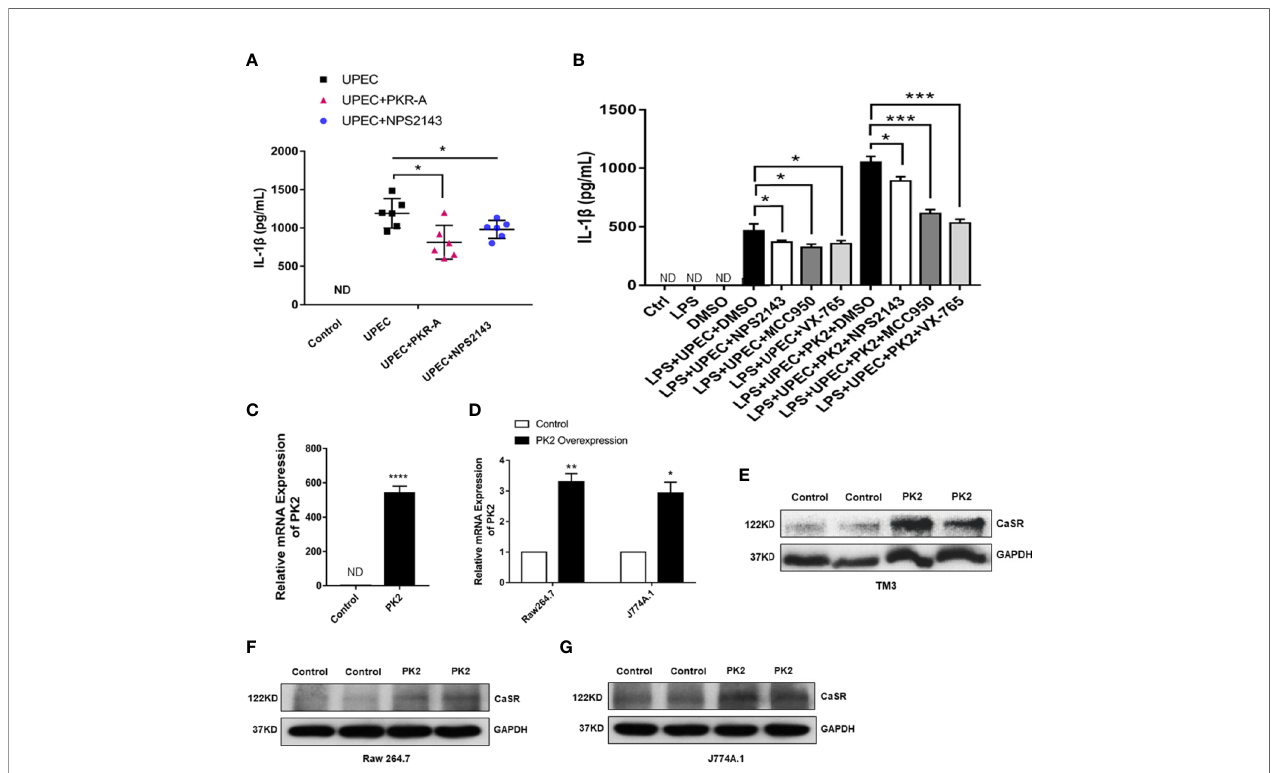
FIGURE 5 | NPS2143 blocks the PK2/CaSR pathway and promotes IL-1 b secretion. (A) Testicular interstitial fl uid was collected from each group, and IL-1 b level in the primary TM interstitial fl uid was analyzed by ELISA ( n = 6/group). (B) LPS, 5% DMSO, 20 mg/kg NPS-2143, MCC950, VX-765, LPS + UPEC + PK2 + DMSO, LPS + UPEC + PK2 + NPS2143, LPS + UPEC + PK2 + MCC950, and LPS + UPEC + PK2 + VX-765 were used to stimulate macrophages for 120 min, and cell supernatants were collected. IL-1 b levels in the supernatants of the primary TM were analyzed by ELISA ( n =5/group). MCC950 was an inhibitor of NLRP3 protein, and VX-765 was an inhibitor of Caspase-1. (C) Transfection ef fi ciency of PK2 in TM3 cell line ( n =3/group). (D) Transfection ef fi ciency of PK2 in RAW 264.7 and J774A.1 (n=3/group). (E – G) The protein level of CaSR was detected by Western blotting. * P < 0.05, ** P < 0.01, *** P < 0.001, **** P < 0.0001 ( t